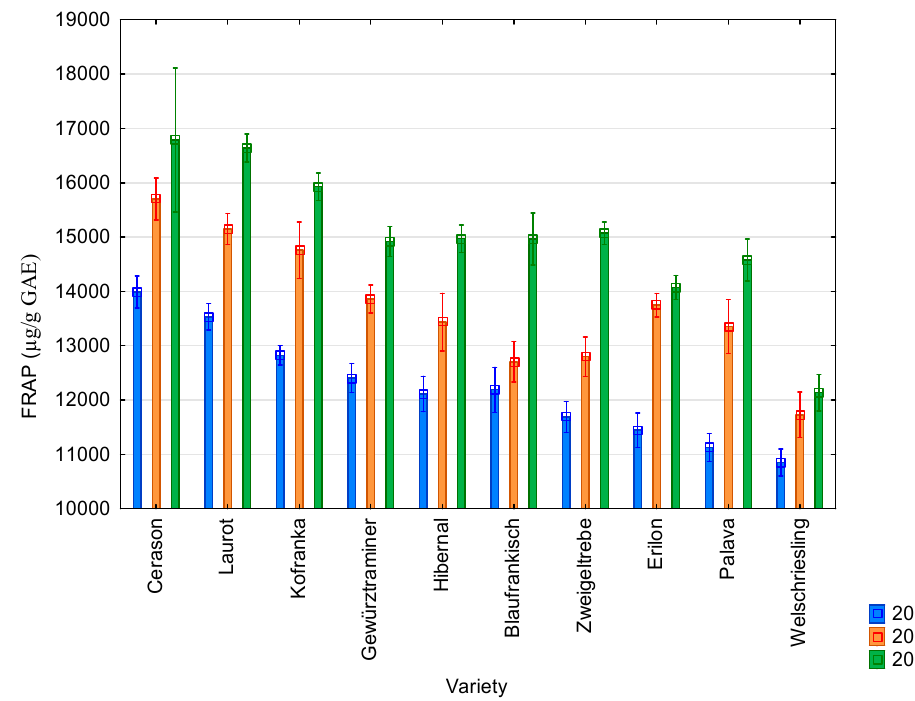
Figure 2. Values of antioxidant activity obtained using the FRAP method for individual vine varieties in 2015 (blue bars), 2016 (orange bars), and 2017 (green bars). 2015: p < 0.01, 2016: p < 0.01, 2017: p < 0.01.